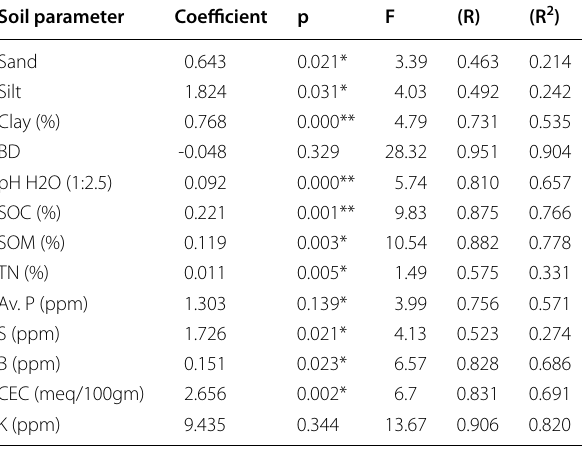
R 2 coefficient of determination **Significance at p <